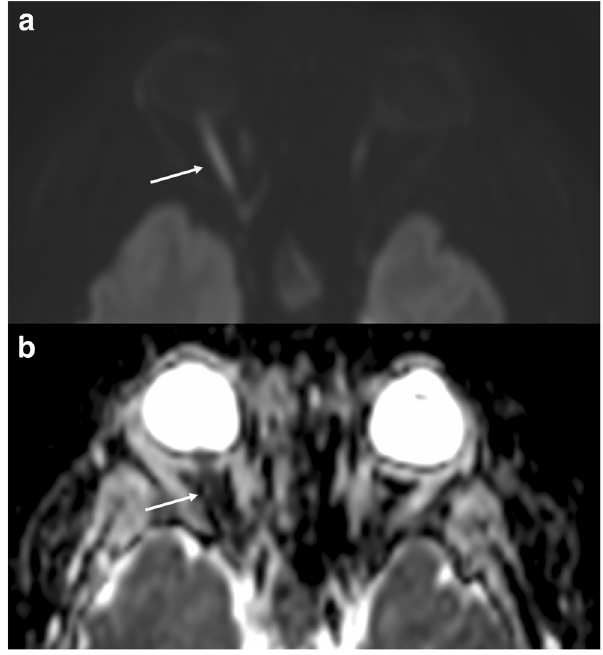
Fig. 11 Optic neuritis. High DWI signal ( a ) and low ADC value ( b ) representing restricted diffusion in the right optic nerve in a patient with non-specific optic